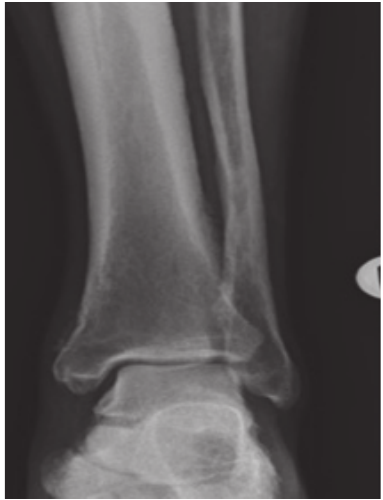
Figure 2: Courseperiosteal thickening along distal tibia and fibulae.